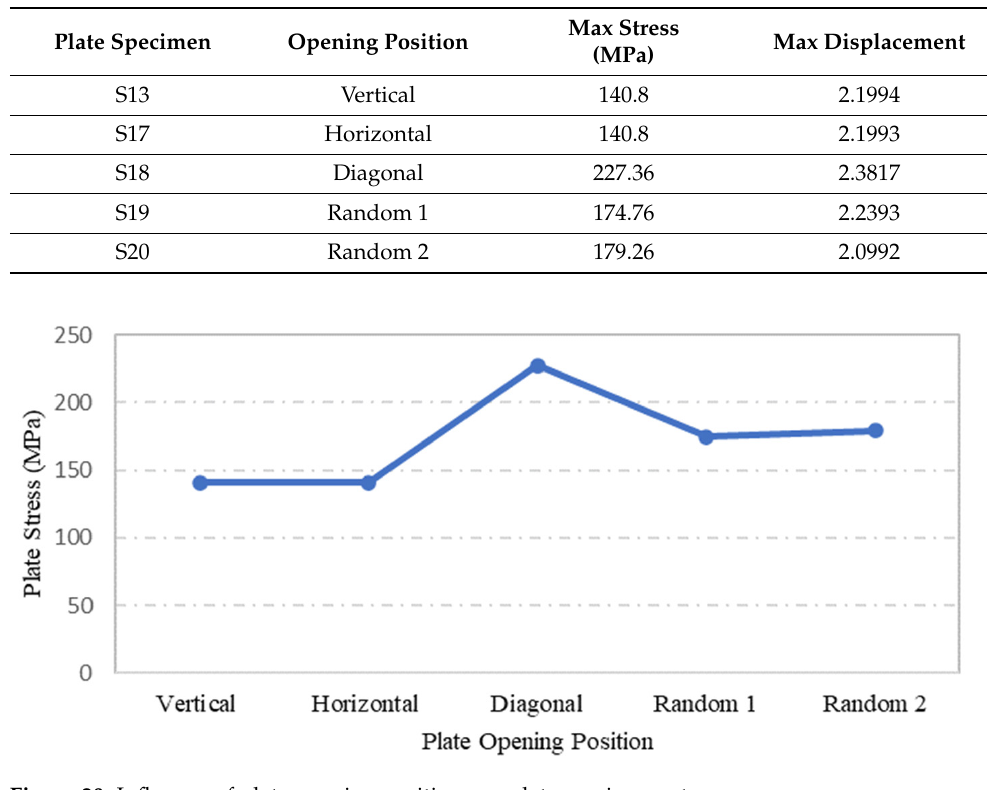
Figure 21. Influence of plate opening positions on plate maximum displacement. The highest maximum stress for all the plate specimens occurred at the time where the applied pressure was at its peak of 0.1 MPa. The plate specimen S-18, yielded the high- est maximum stress also achieved the largest maximum stress results over the time inter- val, as shown in Figure 22.